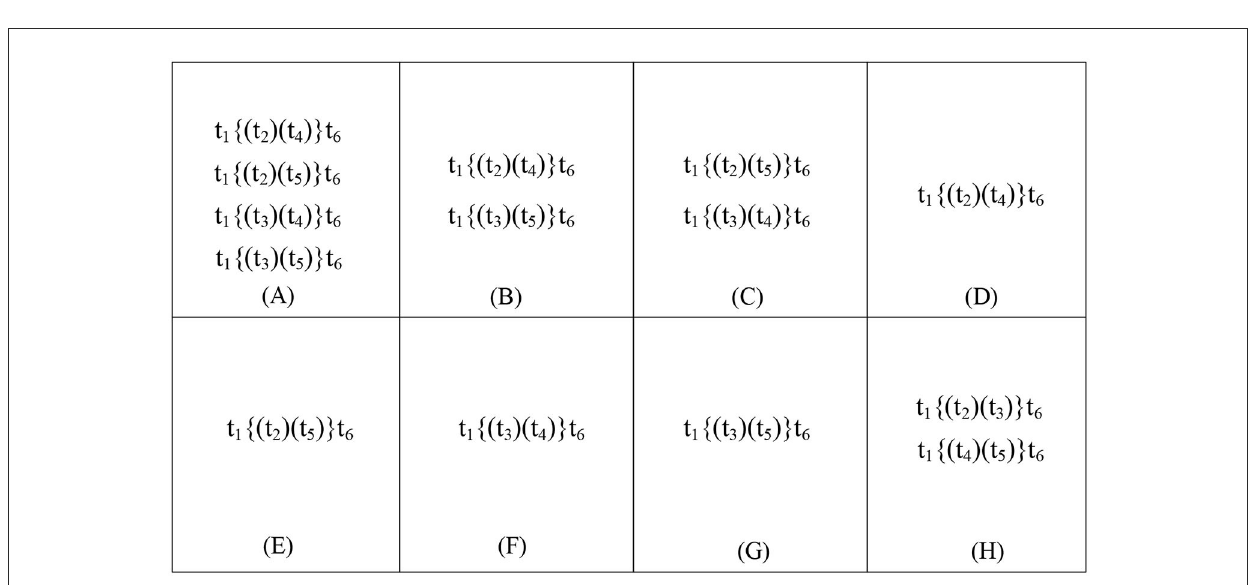
FIGURE5 (A–D) are WFD-net models of Table 2.